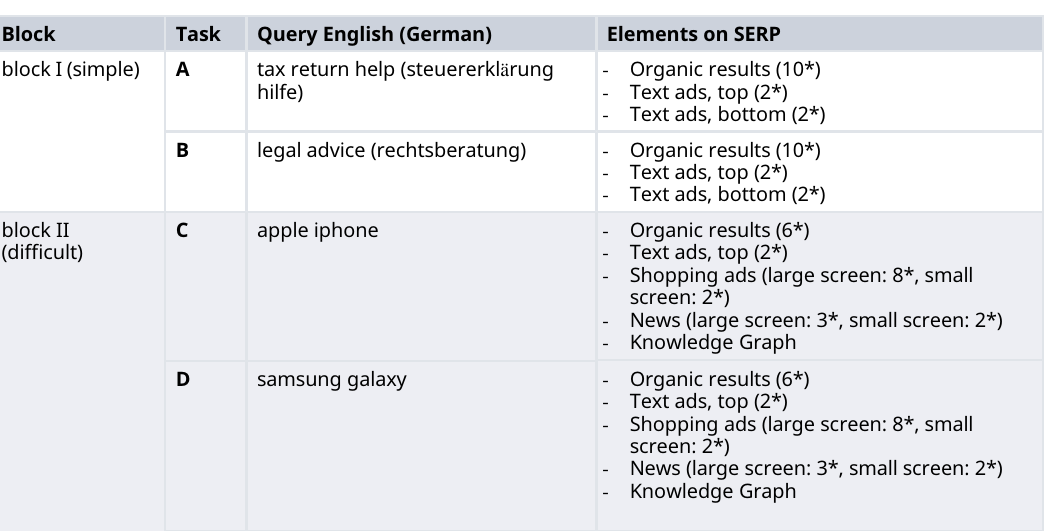
Table 2. Marking tasks: queries and elements of